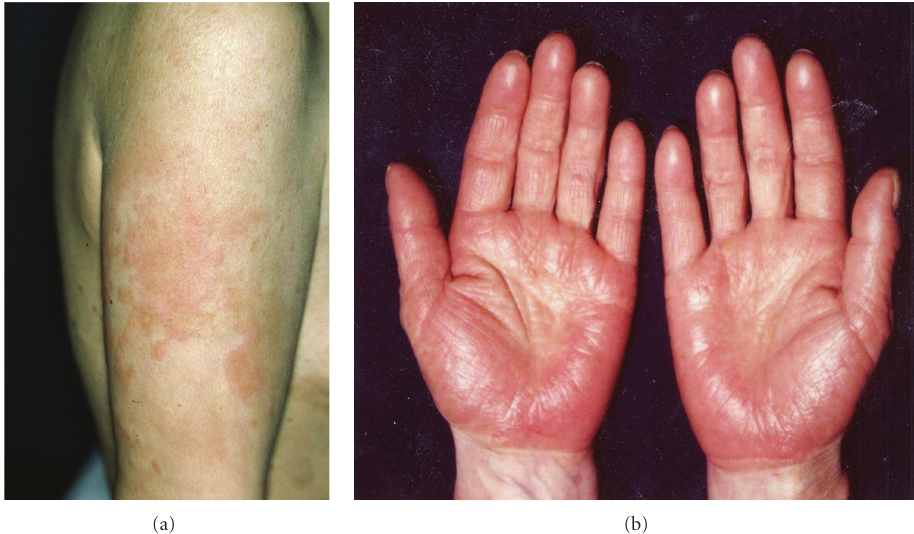
Figure 1: (a) A 49-year-old Japanese female with a di ff use edematous erythema with papules over her entire body. (b) The oral challenge test with zinc sulfate caused exacerbation of the preexisting eruptions on her palms, including itching edematous